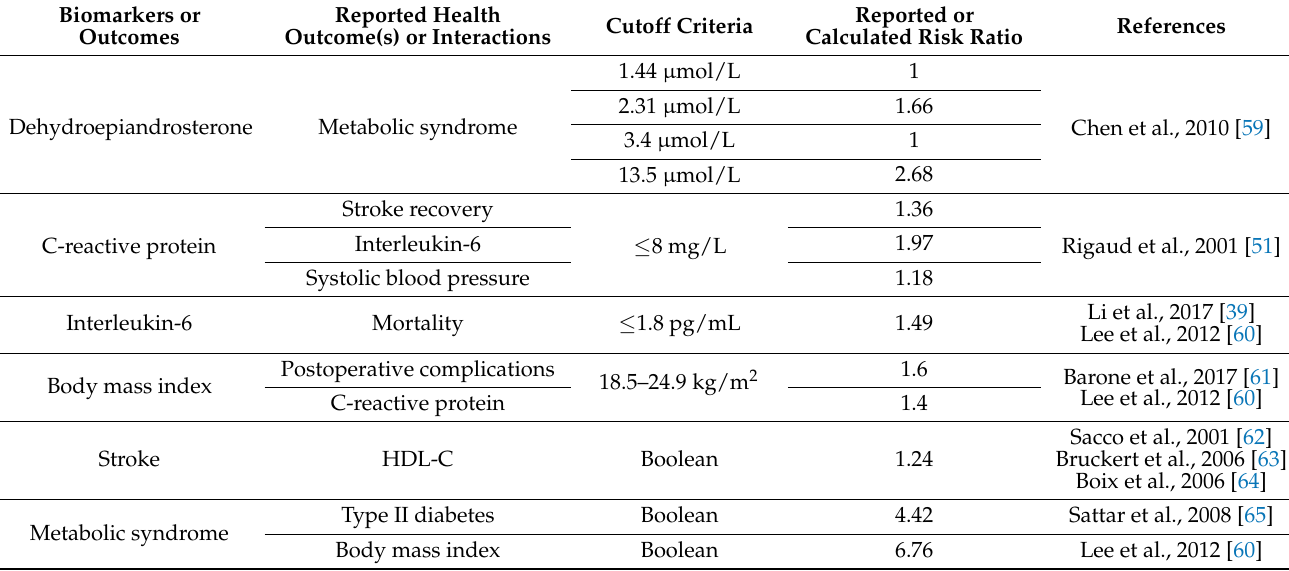
Table 2. Applied statistics for the probability model (see Figure 3), including references.